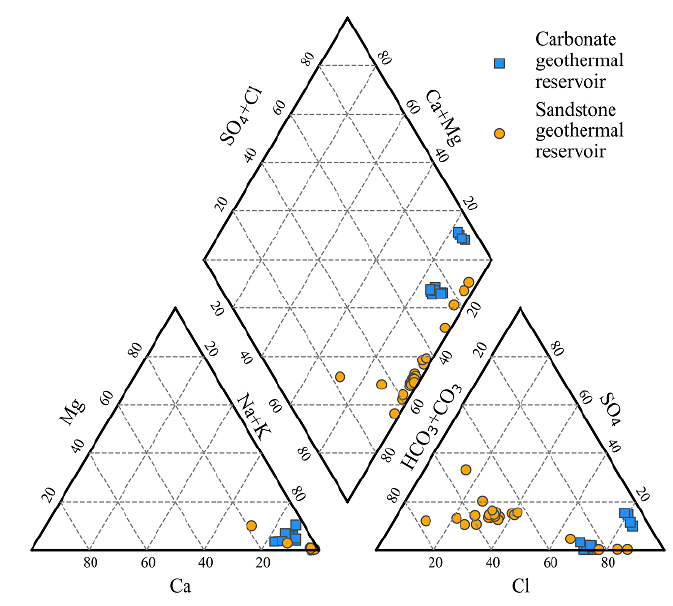
Figure 2. Geothermal fluid Piper trilinear diagram.